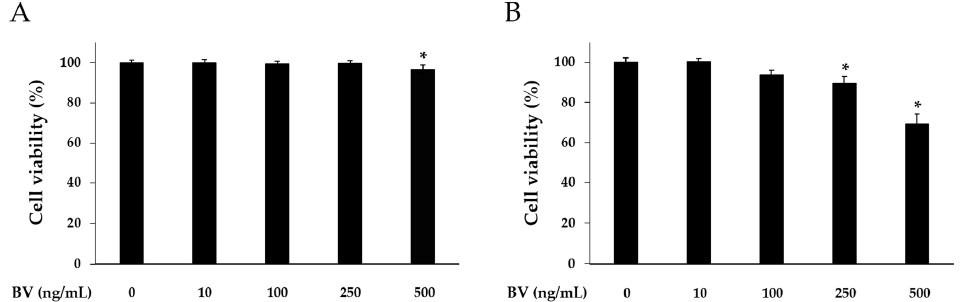
Figure 1. Cytotoxic effects of BV on HaCaT cells. Cytotoxicity of bee venom was determined by CCK-8 assay. HaCaT cells were treated with 1, 10, 100, 250, and 500 ng/mL of BV for 8 h ( A ); and 24 h ( B ). Results are expressed as the means ± SEM of three independent determinations. * p < 0.05 compared to the untreated group.